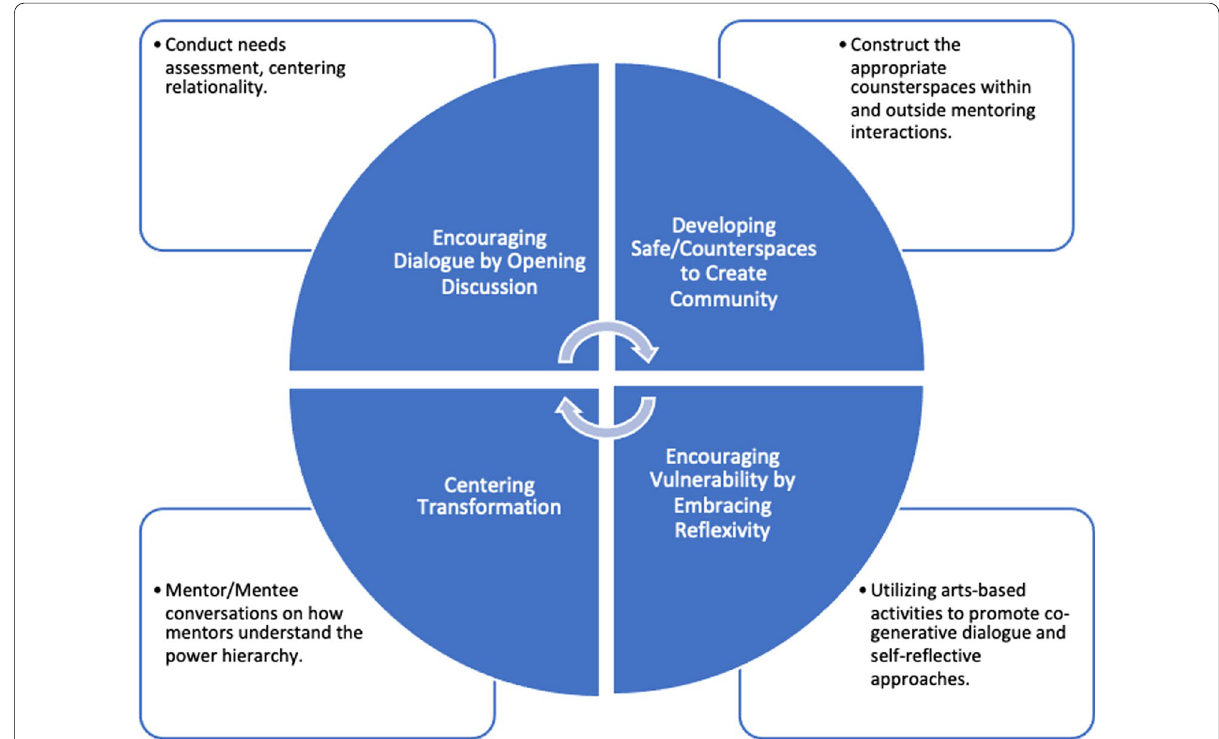
Fig. 3 Recommendations for conceptualizing intersectionality in STEM